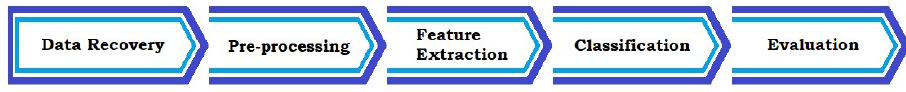
Figure 1. Flowchart of the methodology